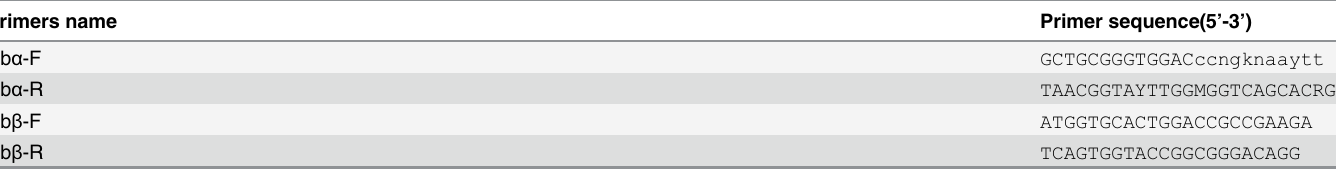
Table 1. Primer sequence used for RACE amplification.